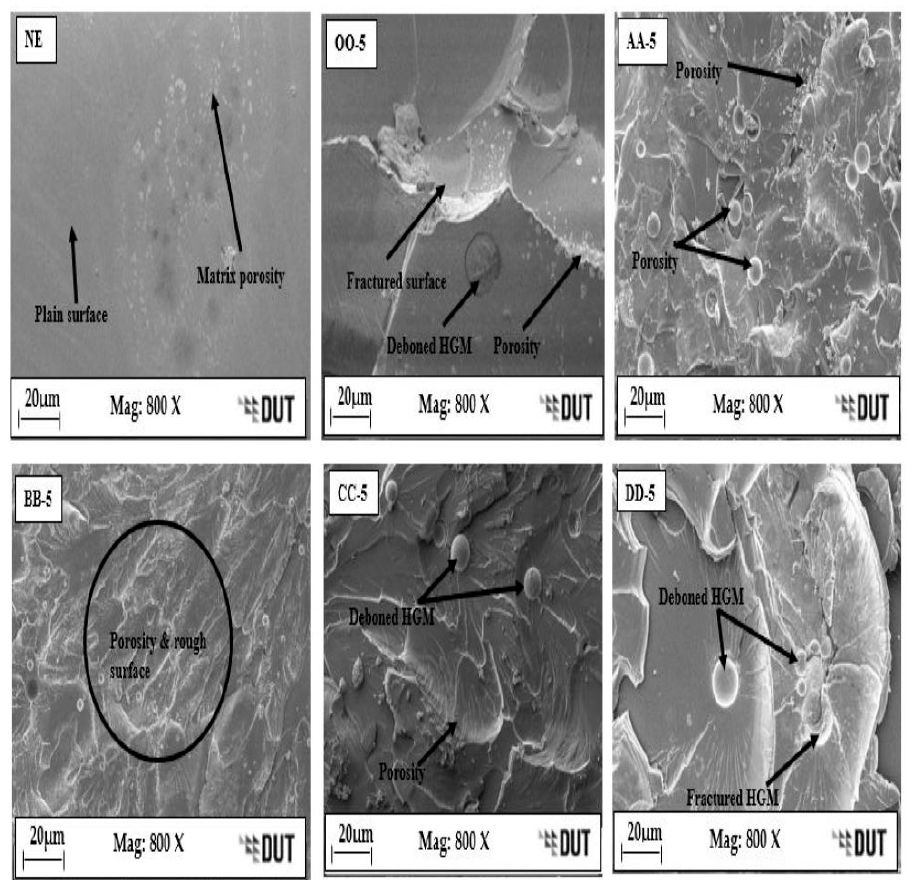
Figure 8. SEM images of the tensile fractured surfaces for the neat epoxy “NE”, OO–5, AA–5, BB–5, CC–5, and DD–5, showing matrix porosity, deboned HGM and rough surfaces.